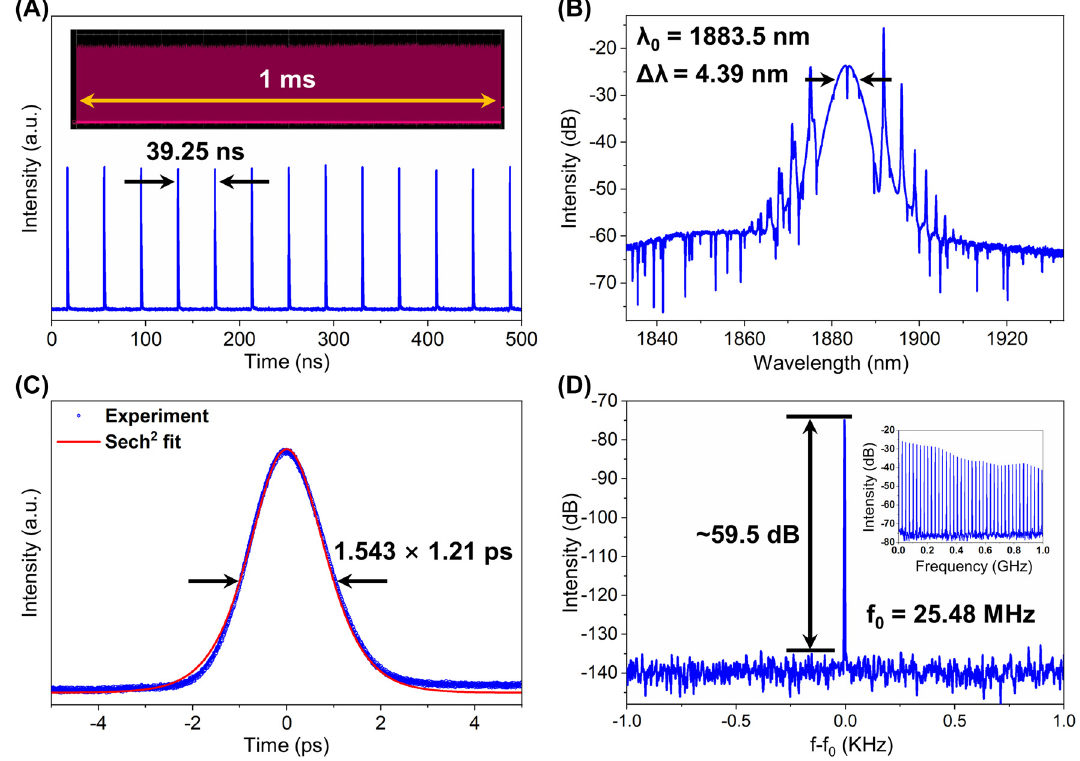
Figure 9: Conventional solitons for mode-locked TDFL. (A) Oscilloscope trace; (inset: 1.0 ms pulse trains); (B) optical spectrum; (C) autocorrelation trace; and (D) RF spectrum with 1 Hz resolution in the range of 2 kHz (inset: RF spectrum with 100 kHz resolution in the range of 1